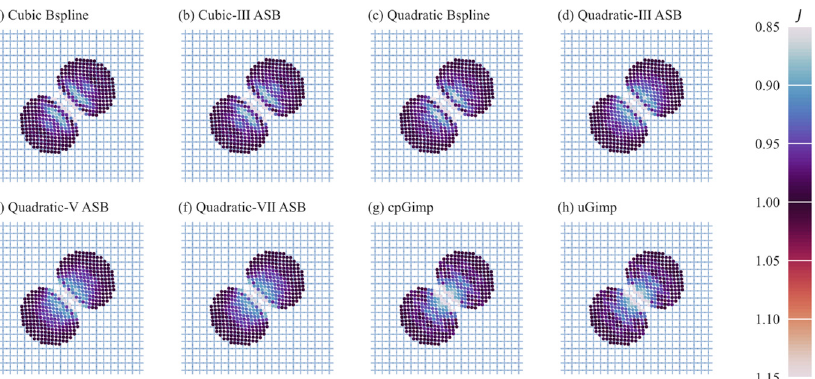
Figure 13. Impact comparison of 2D disks’ collision problem under different MPM shape functions: ( a ) cubic B-spline, ( b ) cubic-III ASB, ( c ) quadratic B-spline, ( d ) quadratic-III ASB, ( e ) quadratic-V ASB, ( f ) quadratic-VII ASB, ( g ) cpGIMP, ( h ) uGIMP. The moment t = 2.0 s when disks deform the most is chosen. Each particle is colored according to the volume ratio 𝐽 to reflect deformation distribution.